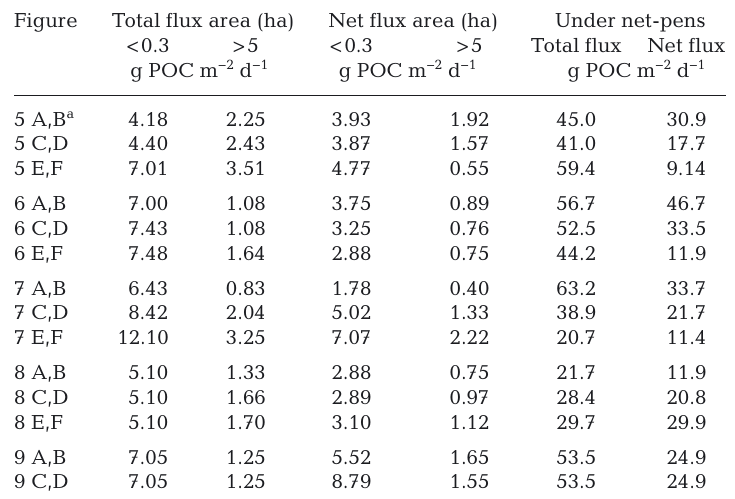
Figure Total flux area (ha) Net flux area (ha) Under net-pens <0.3